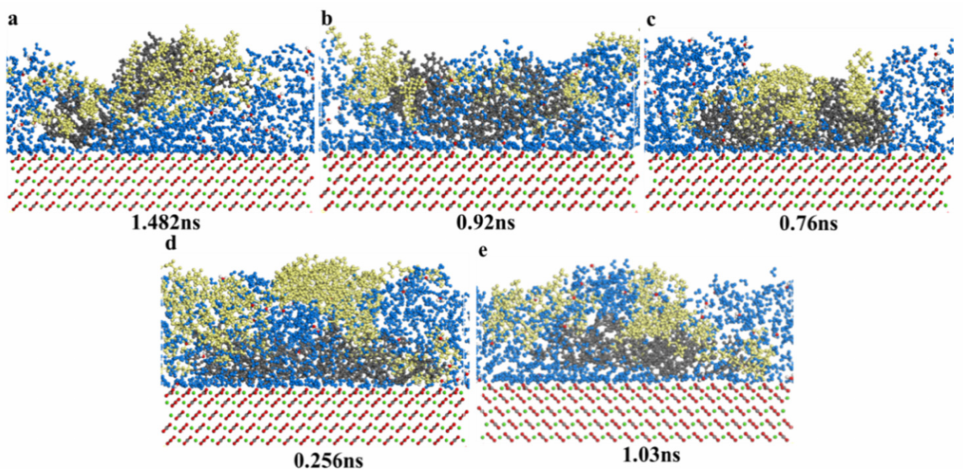
Figure 11. Consecutive snapshot of desorption of aromatics from a modeled calcite surface im- mersed in ( a ) CTAB; ( b ) SDS; ( c ) TX-100; ( d ) sophorolipid; ( e ) rhamnolipid-water system just right. Blue = water; black = aromatics; red = calcite surface; yellow =